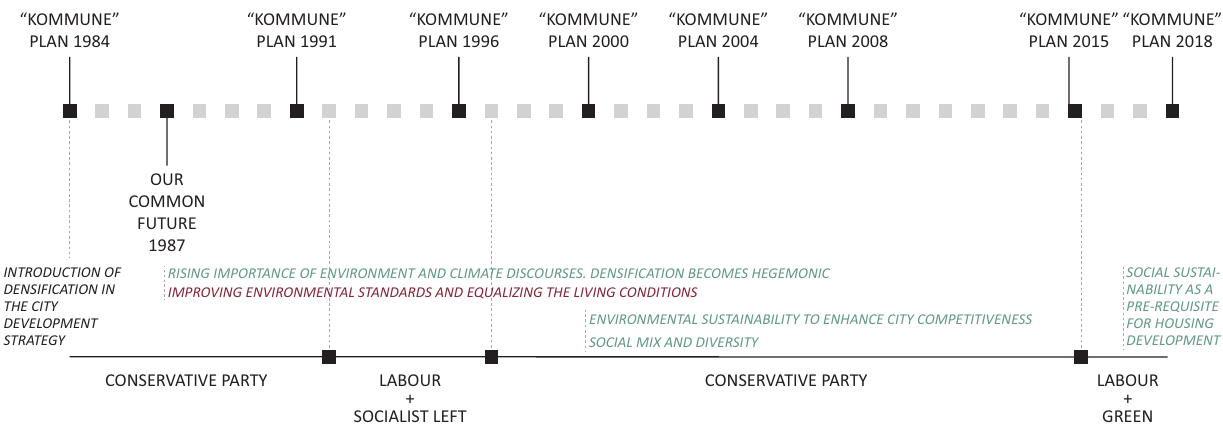
Figure 2. Municipal plans trajectory since the introduction of densification strategies. In red the wide longstanding city vision, in green emerging discourses. Source: Authors’ elaboration based on the qualitative analysis of the municipal mas- terplans (‘Kommune plan’) of Oslo (Oslo Kommune, 1984, 1991, 2000, 2008, 2015b, 2018).